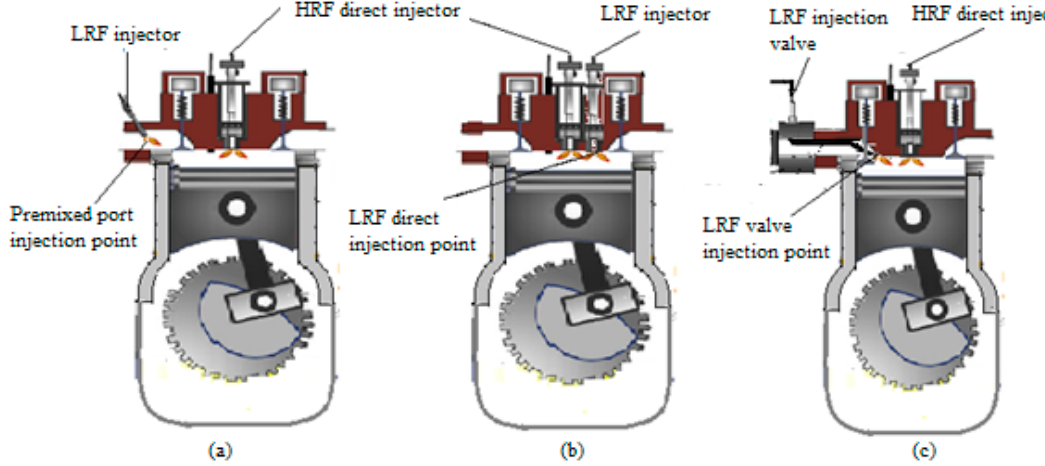
Figure 1. Comparative methods of low reactivity fuel (LRF) delivery in the reactivity controlled compression ignition (RCCI) engine: ( a ) conventional premixed port injection, ( b ) dual direct injection, and ( c ) proposed injection at the valve.